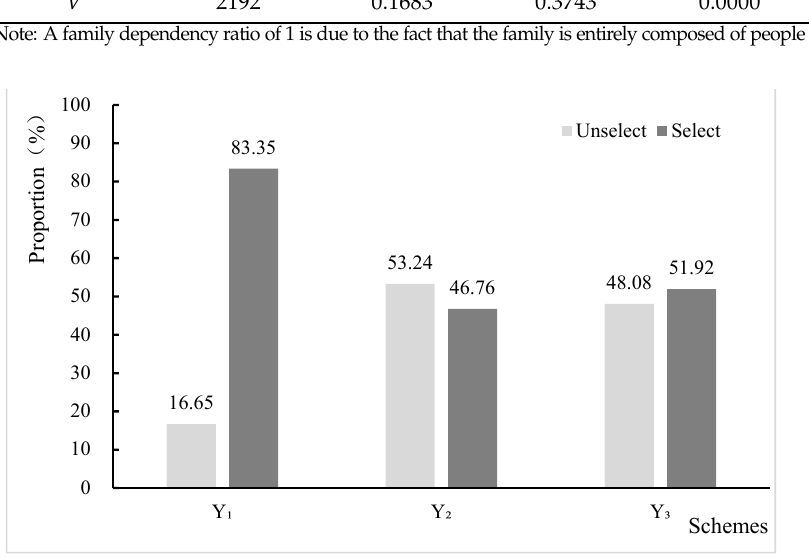
Figure 4. Residents’ preferences for multiple compensation schemes for CLR.